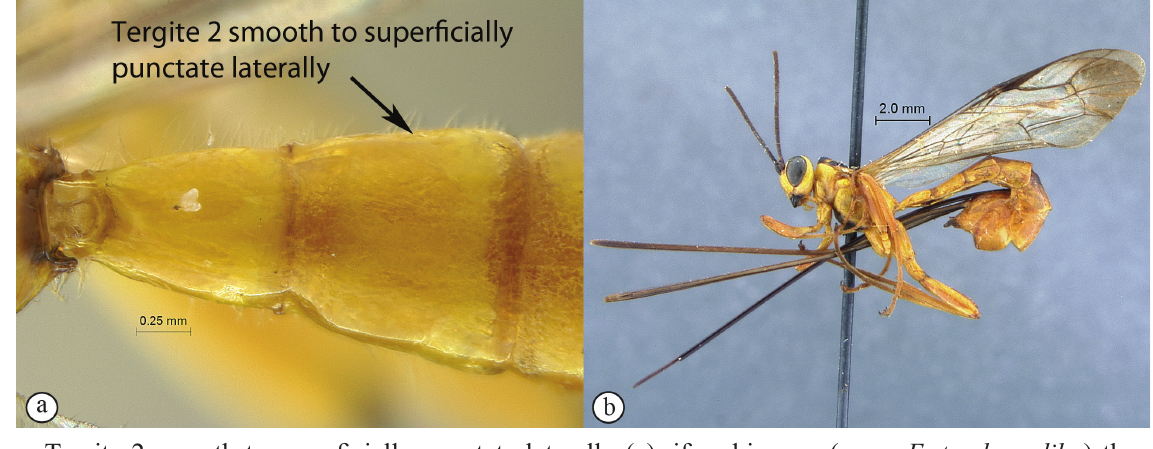
- Tergite 2 smooth to superficially punctate laterally (a), if ambiguous (some E. tombeaodiba ) then tergite 1 stouter, less than 1.5x longer than apically wide; general coloration bright yellow